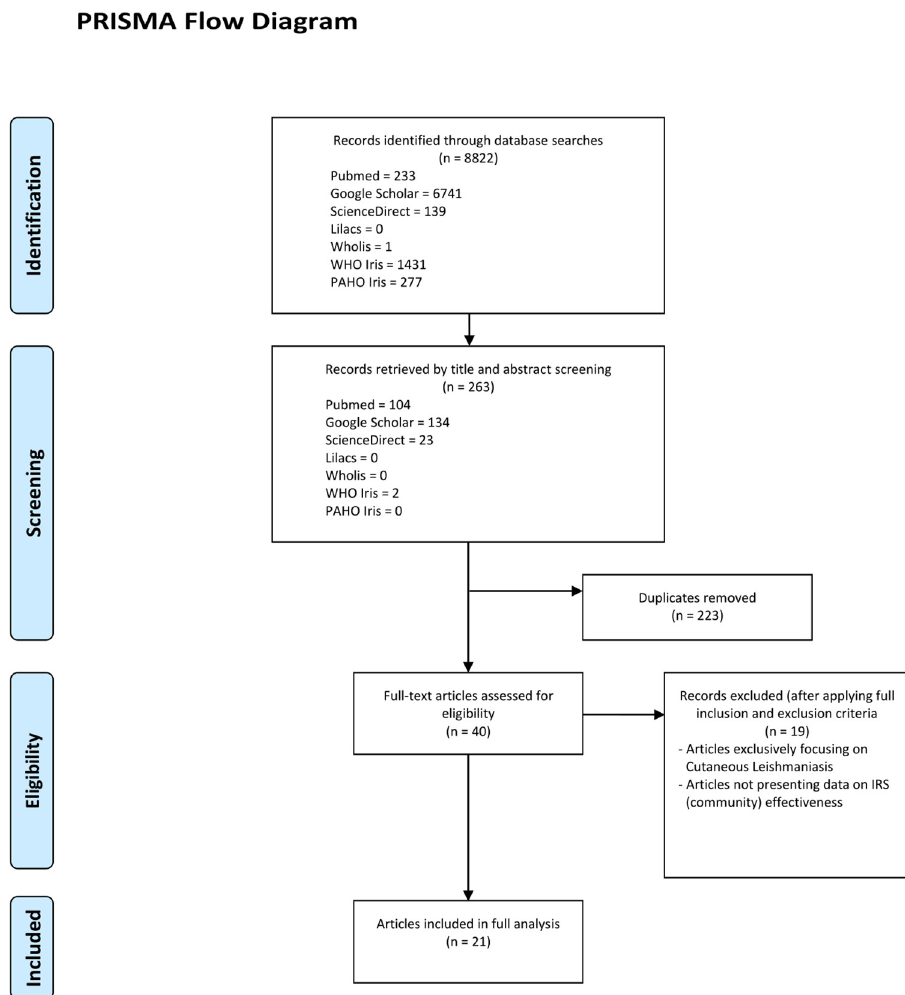
Fig 1. PRISMA flowchart for searches and inclusion of articles for Systematic Review on the use of indoor residual spraying for visceral leishmaniasis control [13].